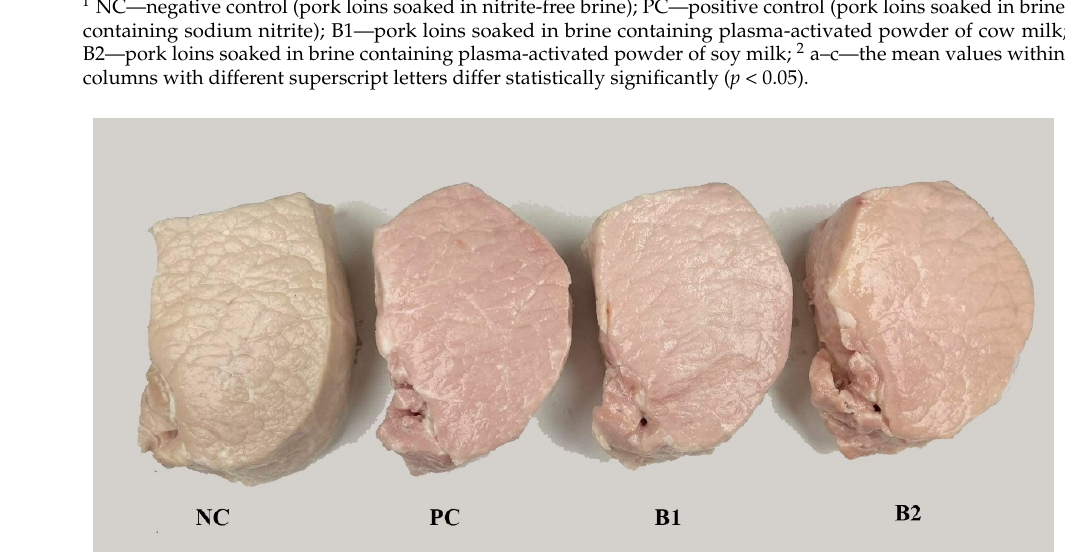
Figure 3. Cured pork loins–top view; NC—negative control (pork loins soaked in nitrite-free brine); PC—positive control (pork loins soaked in brine containing sodium nitrite); B1—pork loins soaked in brine containing plasma-activated powder of cow milk; B2—pork loins soaked in brine containing plasma-activated powder of soy milk.